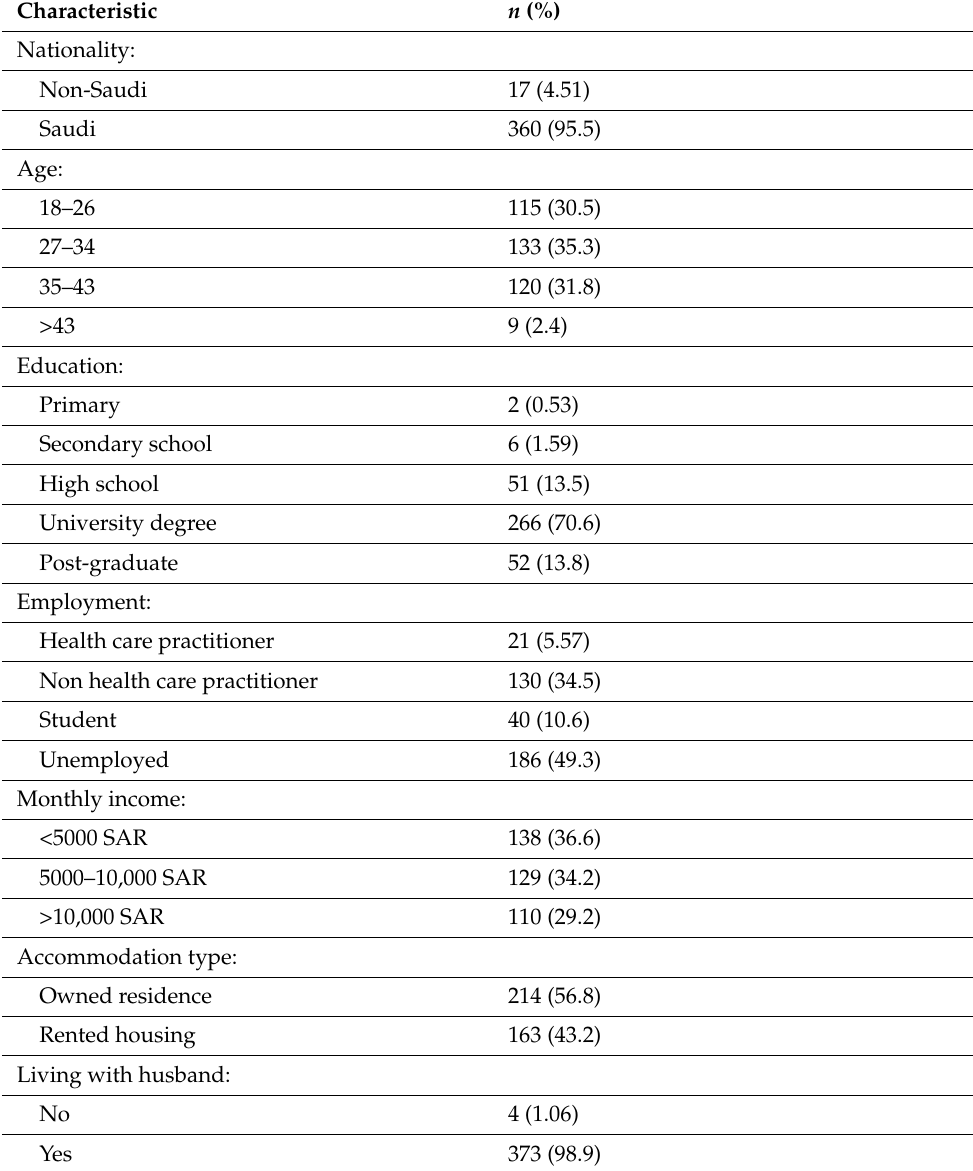
Table 1. Participants’ ( n = 377) demographic